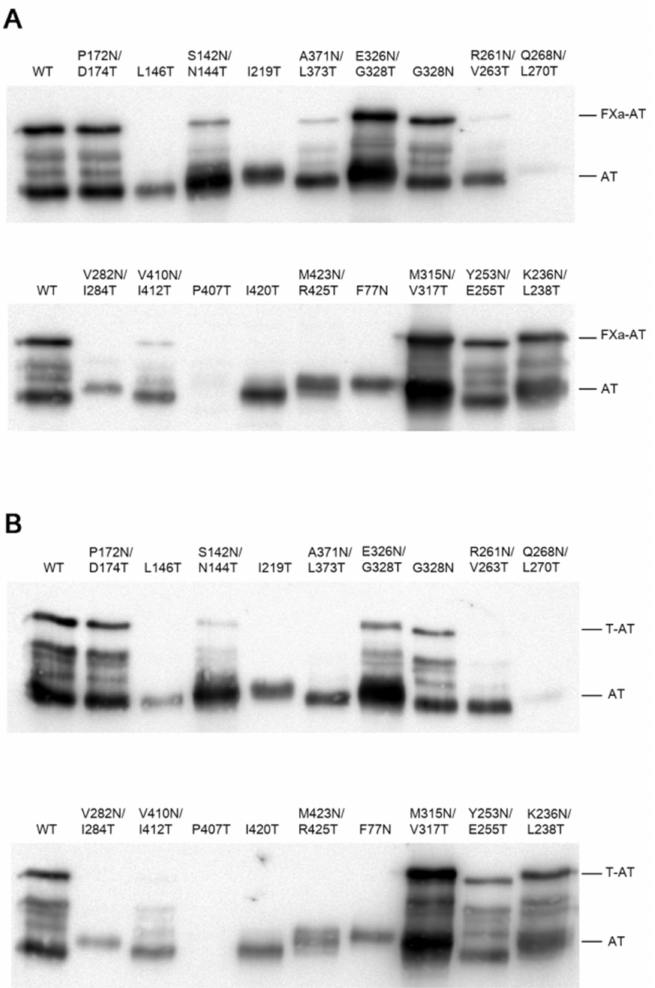
Figure 3. Inhibitory activity of antithrombin mutants. SDS-PAGE under the reduction and Western blot of the medium after 48 h of transfection and later incubation in the presence of low molecular weight heparin or unfractionated heparin with FXa ( A ) or thrombin ( B ). Full-length gels are included in the Supplementary